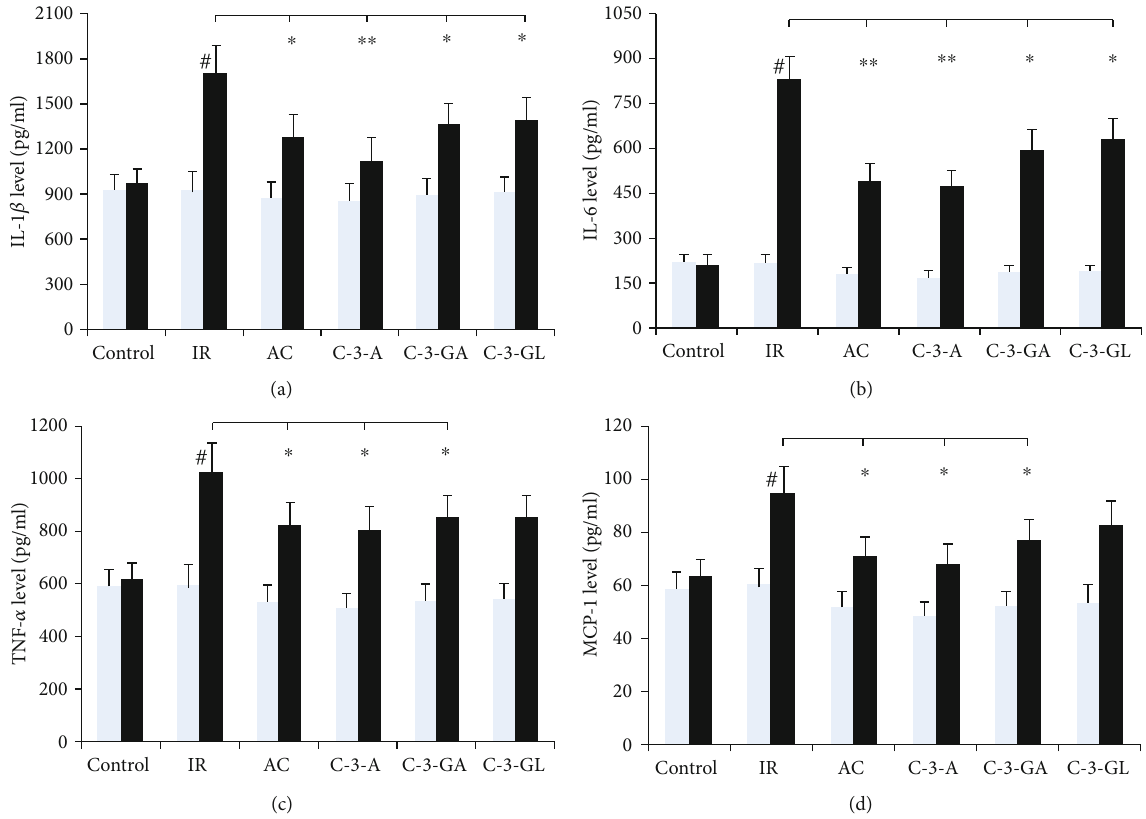
Figure 4: Proin fl ammatory cytokine ’ s levels in the kidney of the renal IR injury and anthocyanin treatment. The data are the means ± SD . n = 13 per group. TNF- α : tumor necrosis factor- α ; IL-1 β : interleukin-1 beta; IL-6: interleukin-6; MCP-1: monocyte chemoattractant protein; IR: ischemic reperfusion; AC: anthocyanins; C-3-A: cyanidin-3-arabinoside; C-3-GL: cyanidin-3-glucodise; C-3-GA: cyanidin-3- galactoside. # P < 0 : 01 vs. control within group; ∗ P < 0 : 05 and ∗∗ P < 0 : 01 vs. respective IR